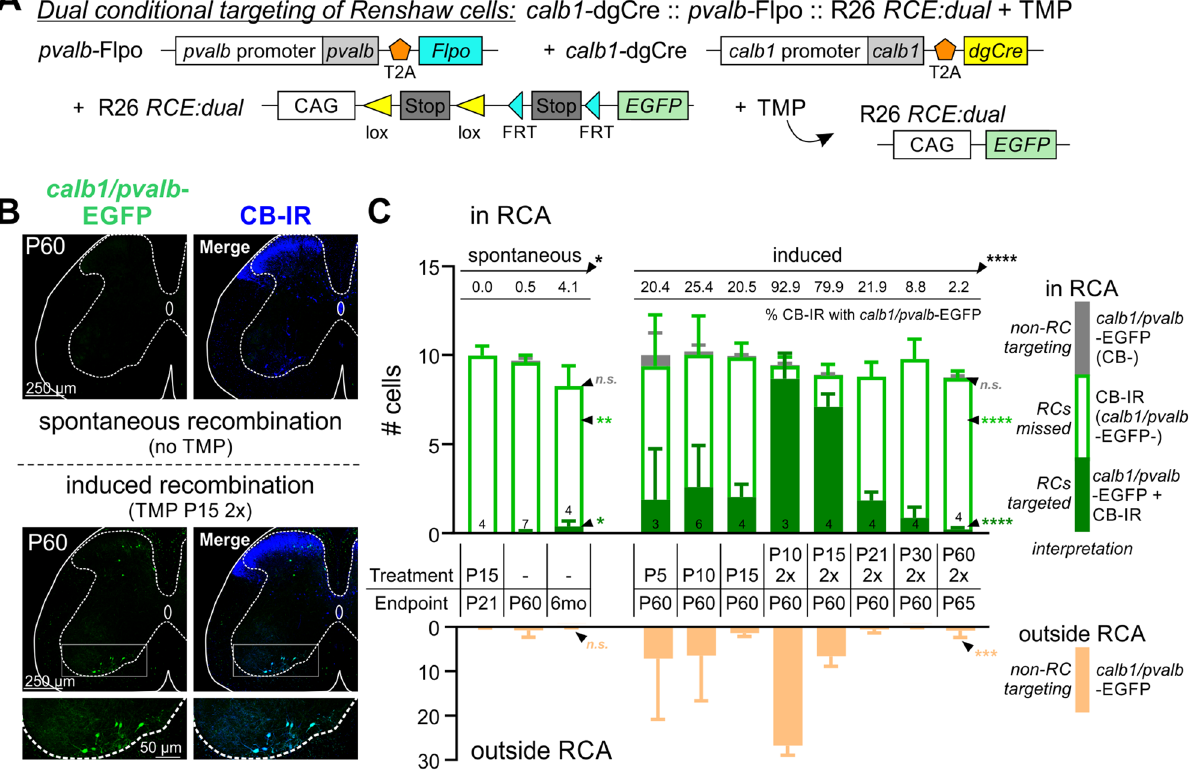
Figure 3. Genetic targeting of Renshaw cells by the intersection of Calb1 -dgCre and Pvalb -Flpo. (A) Schematic of the Calb1 -dgCre :: Pvalb -Flpo :: R26- RCE-dual-EGFP genetic system. Genetic targeting occurs in cells that excise both stop codons in the R26- RCE:dual-EGFP reporter by expressing calbindin at the time of TMP administration and parvalbumin any time prior to age of analysis. ( B) Confocal image stacks (50 µm thick sections) comparing lack of spontaneous recombination labeling (top) or labeling after two TMP injections at P15 and analysis at P60 (bottom) ( Calb1/Pvalb -EGFP, green; CB-IR, blue). Most RCs (higher mag panels) and a few dorsal horn cells express EGFP and CB-IR after TMP administration. ( C) Quantification of Calb1/ Pvalb -EGFP inside and outside the RCA (top and bottom bars, respectively) after TMP or vehicle injections at different time points from P5 to P60 or no injections. The largest percentage of RC labeling occurs after 2 doses of TMP at P10 or P15. The number of non-RCs targeted diminishes after P15 injections compared to P10. In this intersectional Calb1/Pvalb model, there is negligible spontaneous labeling at P60, either in the RCA or outside the RCA. (Error bars = S.D.; asterisks in all graphs indicate significance level after One-Way ANOVAs across all conditions. *p < 0.05; **p < 0.01; ***p < 0.001; ****p < 0.0001, n.s. non-significant. For pair-wise comparisons and details of statistics and analyses, see Supplemental Tables 7–9 and Supplemental Fig.